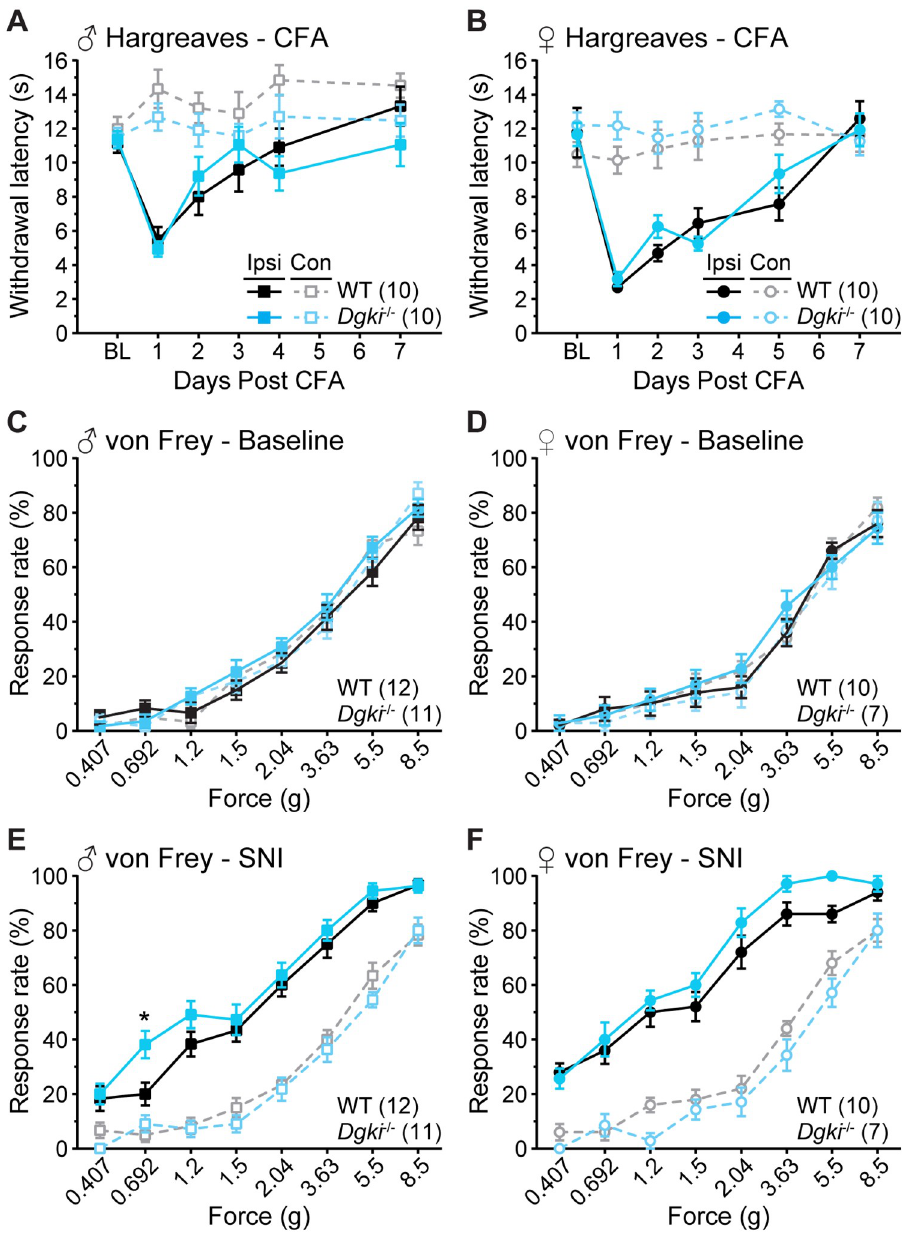
Fig 4. Dgki deletion does not alter sensitization or recovery in chronic inflammatory or neuropathic pain models. Withdrawal latencies to heat in the Hargreaves assay for 7 days following injection of complete Freund’s adjuvant (CFA) into the plantar surface of the ipsilateral and contralateral hindpaws in male (A) and female (B) Dgki -/- and WT mice. BL = baseline. Response rates to von Frey filaments of the indicated forces in male (C,E) and female (D,F) Dgki -/- and WT mice at baseline (C-D) and 14 days after spared nerve injury (SNI) surgery (E-F) in the ipsilateral and contralateral hindpaws. The number of mice tested is indicated in parentheses. Graphs show mean ± SEM. � p < 0.05.